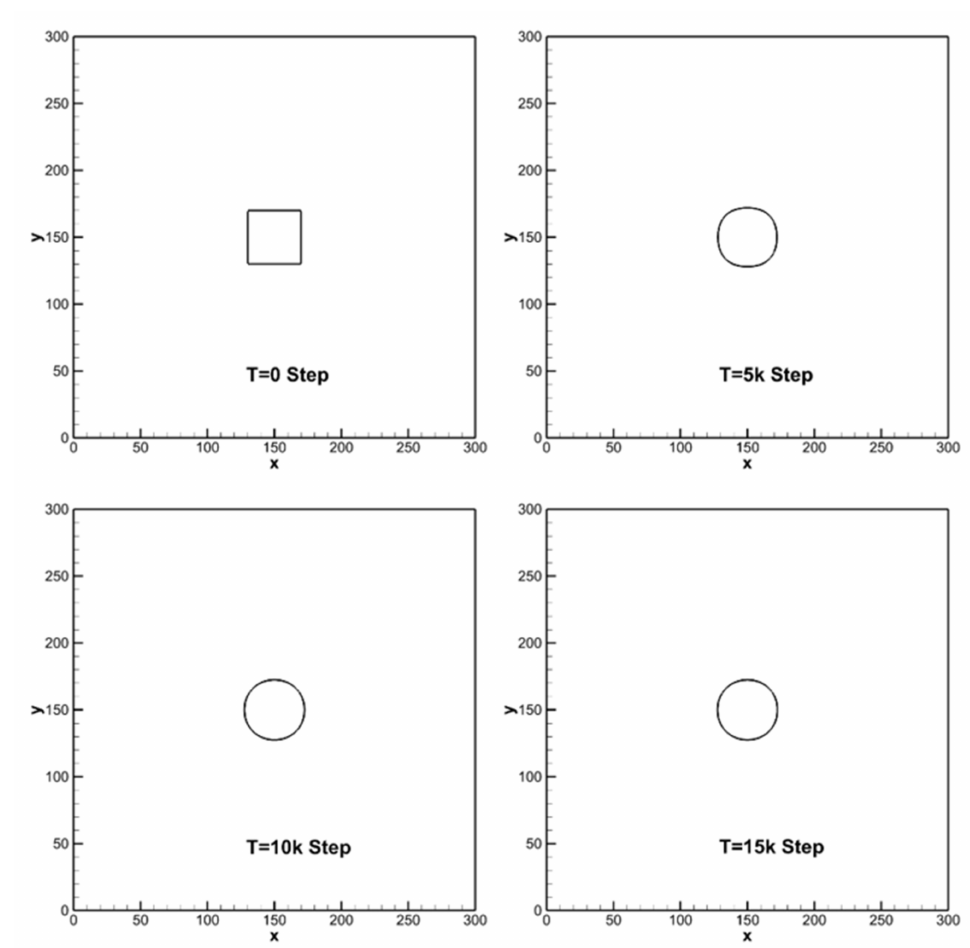
Figure 11. Development of the interface for the square bubble of R = 20.